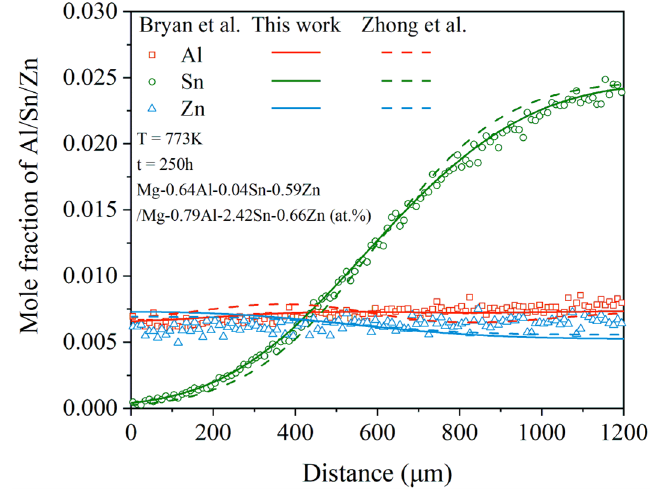
Figure 13. Model-predicted composition–distance profiles of the only quaternary diffusion couple in quaternary system, Mg-0.64Al-0.04Sn-0.59Zn/Mg-0.79Al-2.42Sn-0.66Zn, annealed at 773 K for 250 h from the present atomic mobilities (solid lines) compared with these of Zhong et al. [32] (dashed lines) and the experimental data [33] (in symbols).